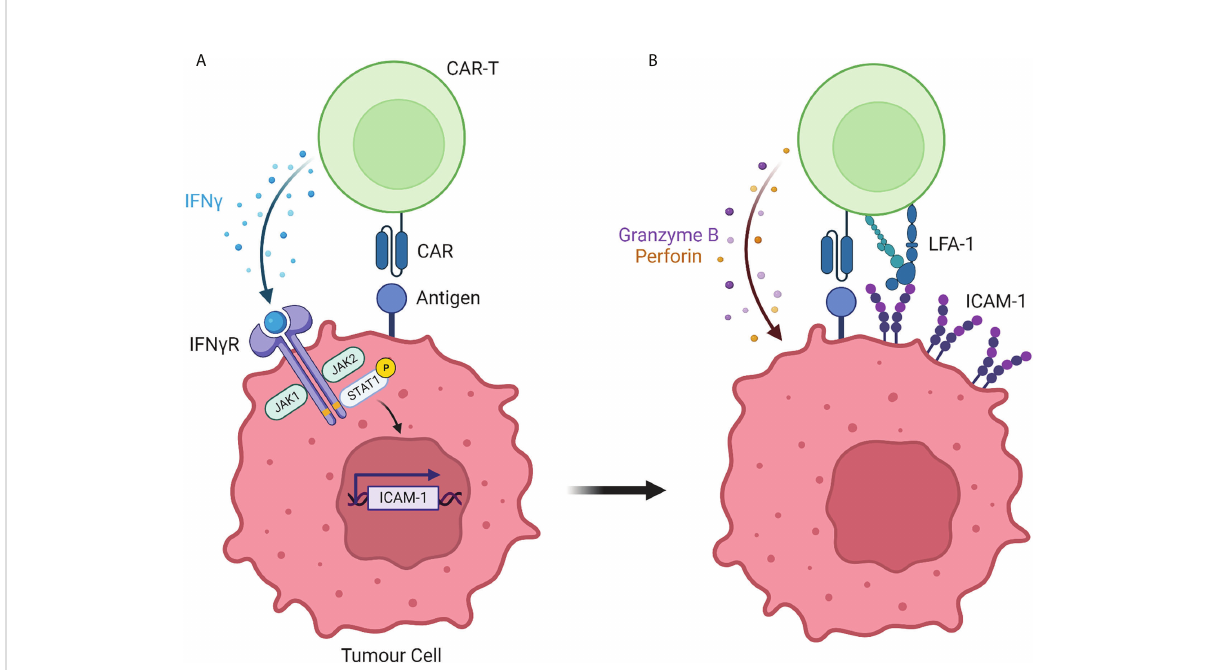
FIGURE 1 The interaction between CAR T cells and solid tumor cells is controlled by the IFN g /ICAM-1 axis. (A) During initial interaction with solid tumor cells, CAR T cells secrete IFN g which induces the transcription of the adhesion molecule ICAM-1. (B) ICAM-1 expression by solid tumor cells strengthens the adhesion with CAR T cells, resulting in tumor cell killing. Created with BioRender